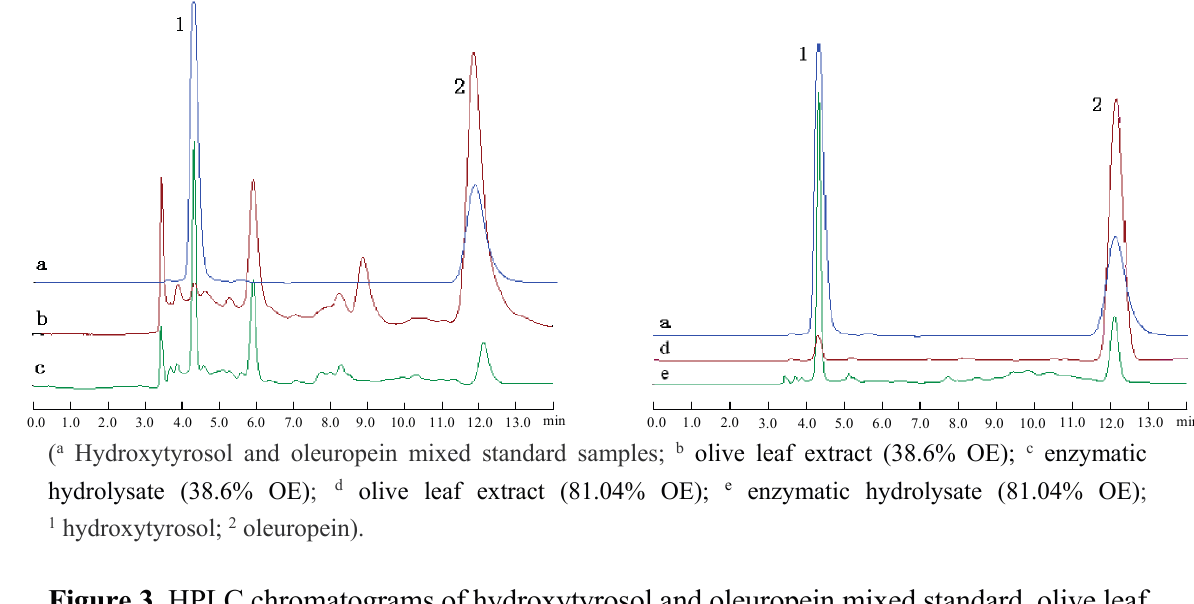
Figure 3. HPLC chromatograms of hydroxytyrosol and oleuropein mixed standard, olive leaf extract (38.6% OE, 81.04% OE) before and after enzymatic hydrolysis with